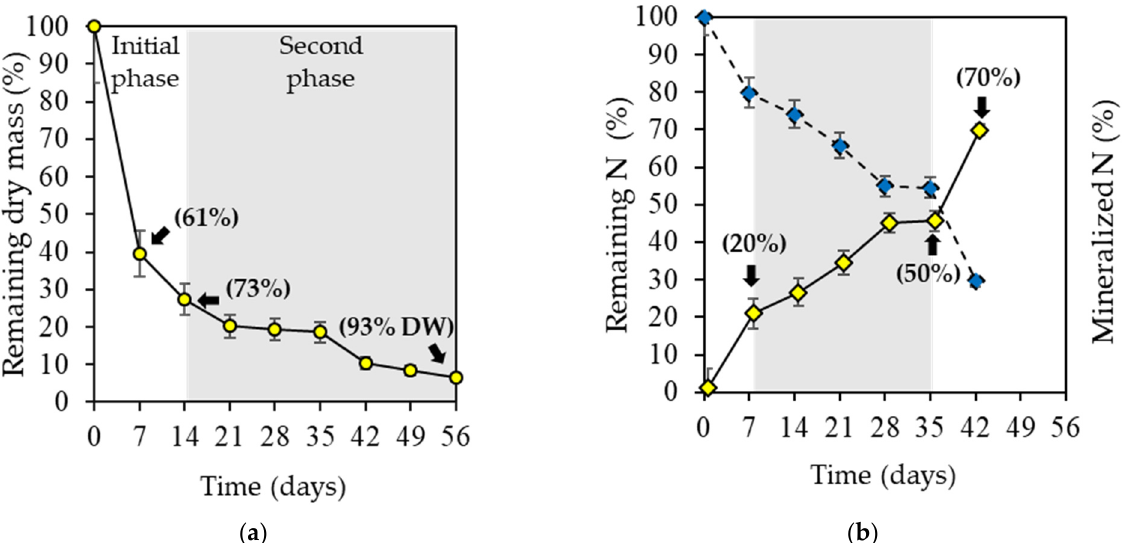
Figure 1. Decomposition and N mineralization of Ulva ohnoi over time after being incorporated into the substrate: ( a ) percentage of biomass remaining (dry weight [DW]) and ( b ) N remaining in the decomposed dry biomass (dotted line) and N released to the substrate (solid line). Values represent mean ± standard deviation (n = 3).